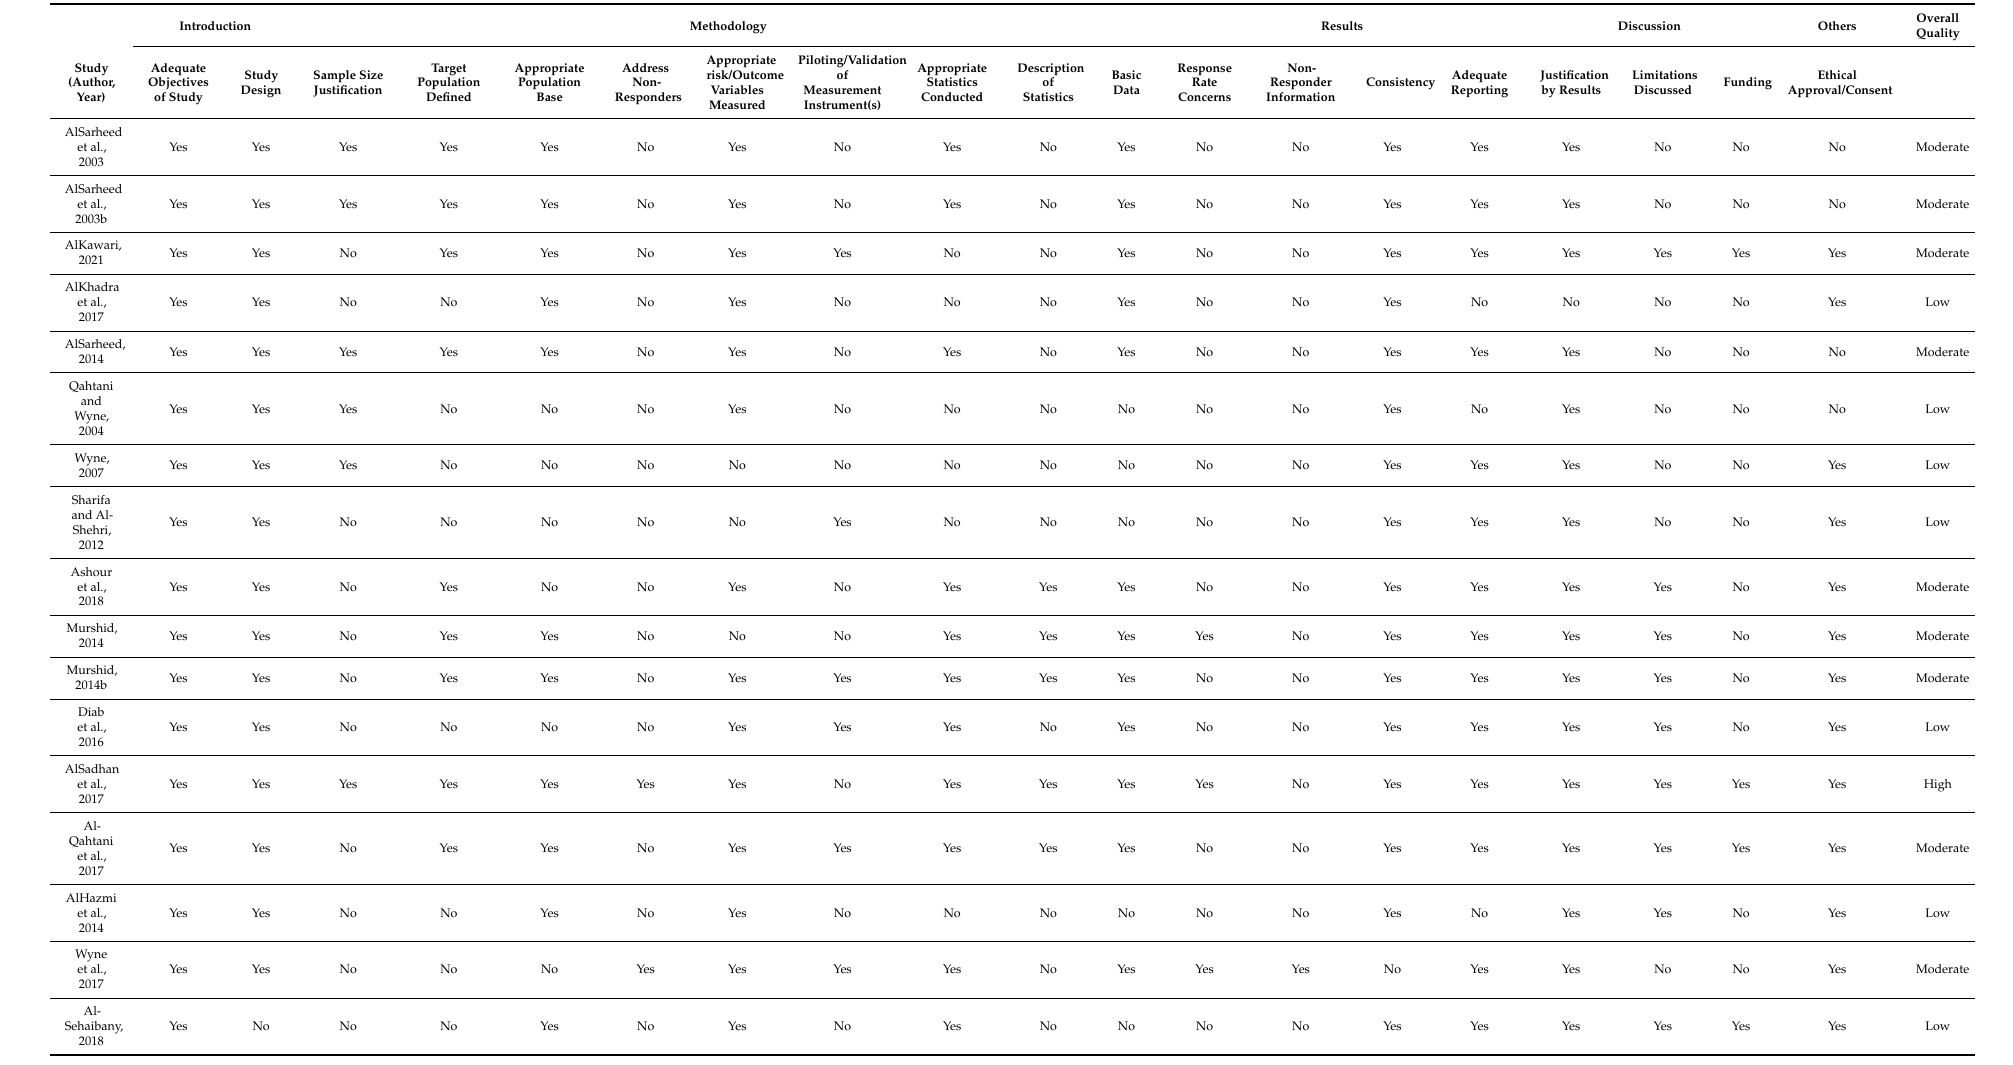
Table 2. Quality